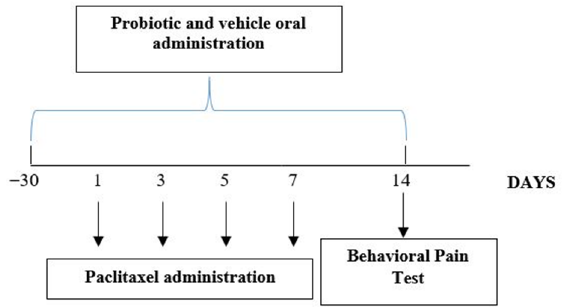
Figure 1. Experimental design showing the time points of probiotic and paclitaxel administration and behavioral